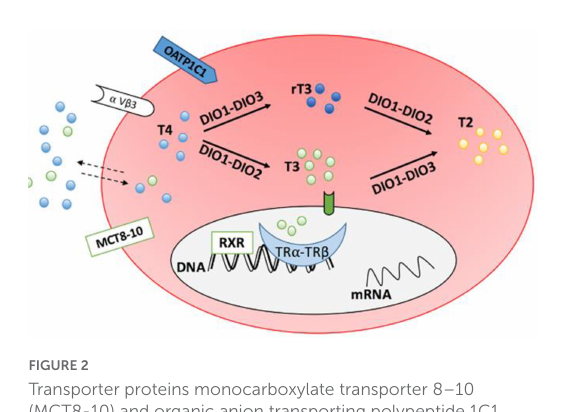
FIGURE2 Transporter proteins monocarboxylate transporter 8–10 (MCT8-10) and organic anion transporting polypeptide 1C1 (OATP1C1) facilitate entry of thyroid hormones into cells. DiO1 and DiO2 convert T4 to T3 (DiO2 is responsible for intracellular conversion while DiO1 is extracellular). DiO1 and DiO3 inactivate T4 by converting it to reverse T3 (rT3). From J. Clin. Med. 2020, 9(6),